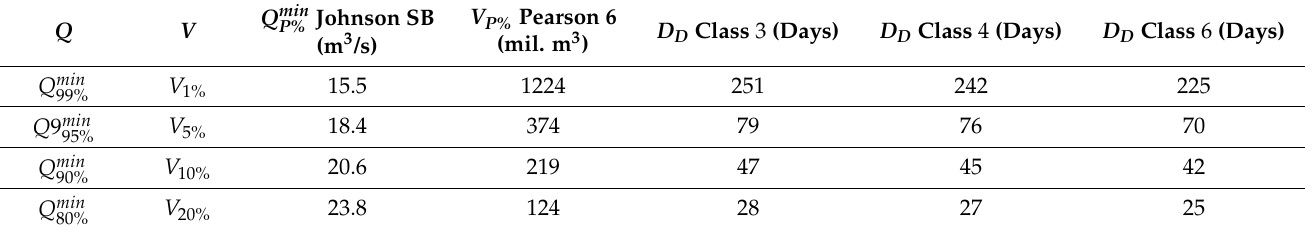
Figure 10. Synthetic drought hydrograph—Class 3.